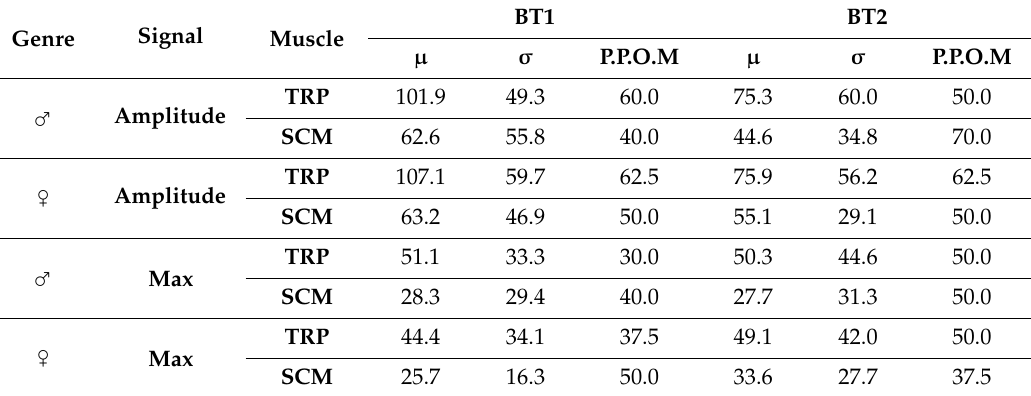
Table 4. Summary of the sEMG data from the experiments: Braking Test 1 (BT1) and Braking Test 2 (BT2). P.P.O.M: Percentage of People Over the Mean, ( µ ) average value and ( σ ) standard deviation.